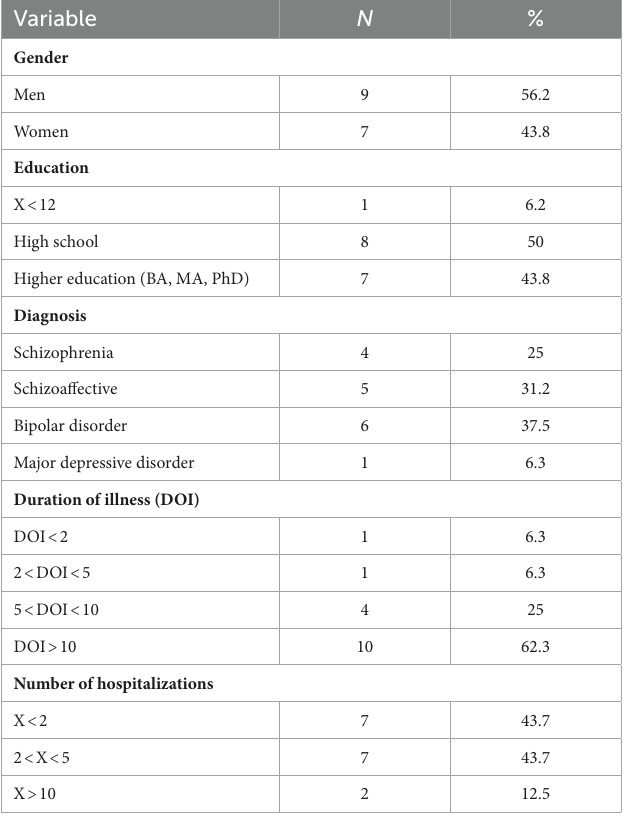
TABLE 1 Sociodemographic and medical background characteristics of the sample.